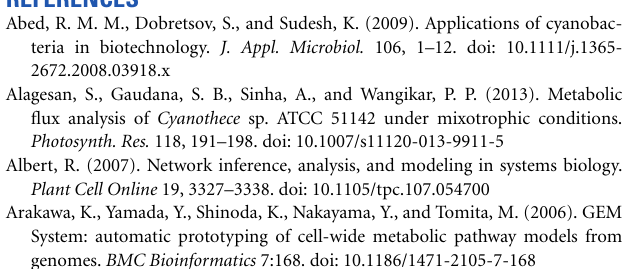
differential expression upon iron depletion at 72h for Synechocystis 6803 (A) and 53h for Prochlorococcus MED4 (B) . Red edges indicate a putative repression by the regulatory element. The apparent differential regulation of cmpA/nrtC is discussed in more detail in the case study. (C) CINPER-generated network created using the keyword set to Fur, with Synechocystis 6803 as the reference organism, and Prochlorococcus MED4 as the